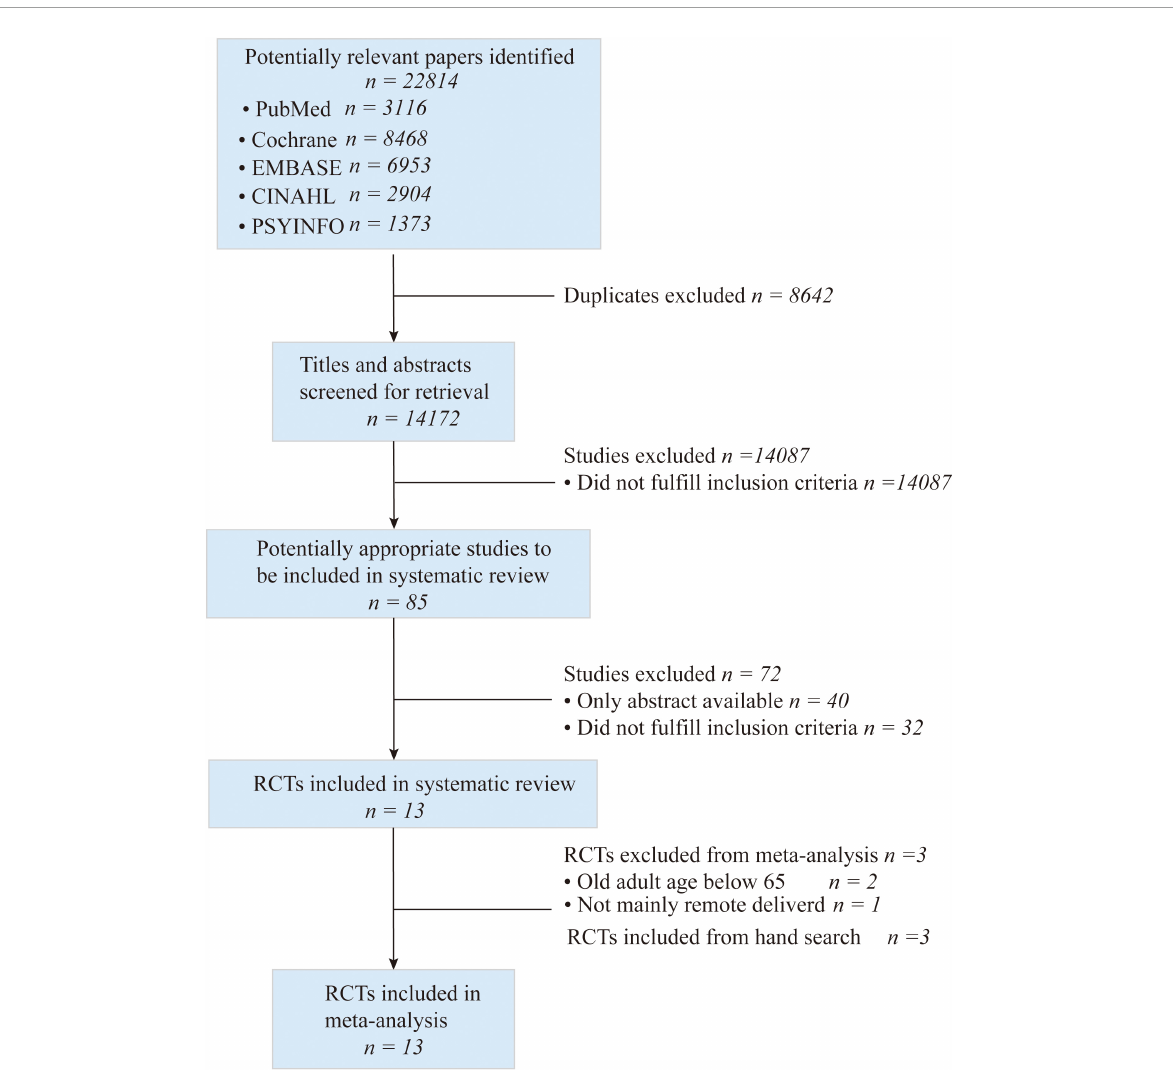
FIGURE1 Flowchart of study